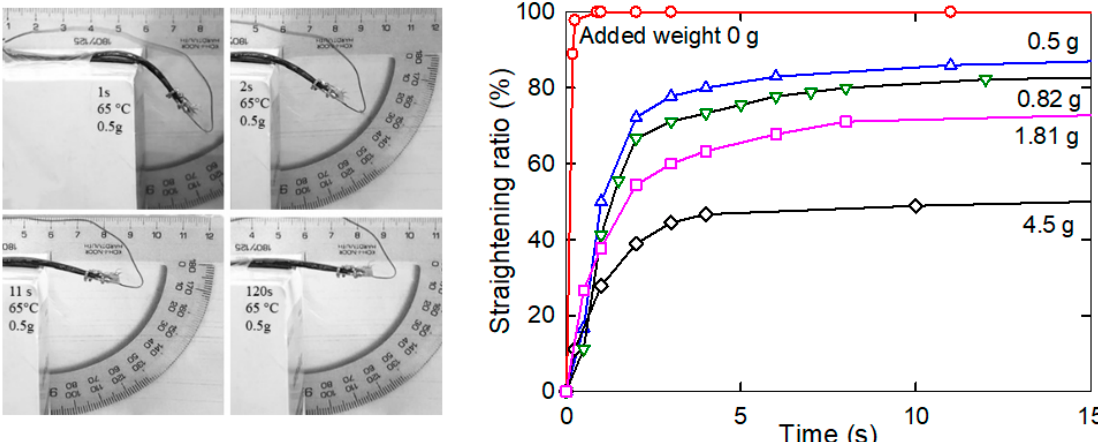
Figure 8. Left : the depiction of the incomplete straightening of the heated bent composite strip loaded with a weight of 0.5 g at indicated times and at a temperature of 65 °C (the entire time course is depicted in the graph with blue open triangles in the adjacent plot). Right : the dependence of the composite strip straightening ratio on time at 65 °C when unloaded (denoted as 0 g, red open circles) or loaded with weights 0.5 g (blue open triangles up), 0.82 g (green open triangles down), 1.81 g (pink open squares) and 4.5 g (dark blue open diamonds).